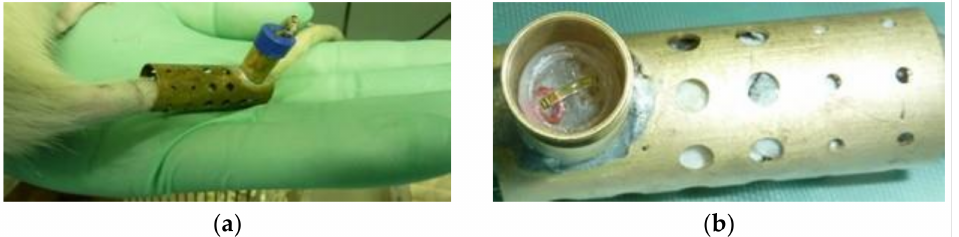
Figure A1. Photos of the pin-port tail cuff in-situ: ( a ) during study data collection periods; ( b ) close-up view of the U-shaped loop during recirculation phases (following surgery or between data collection sessions).